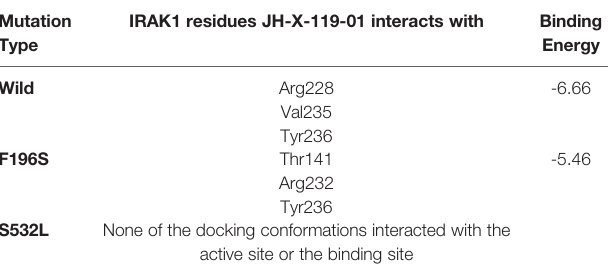
TABLE 4 | Docking energies and ligand-residue